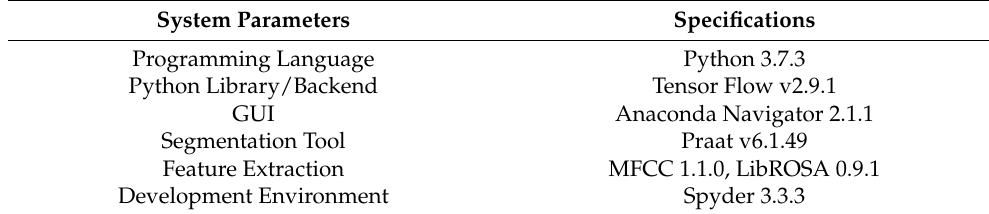
Table 3. Parameters used in current